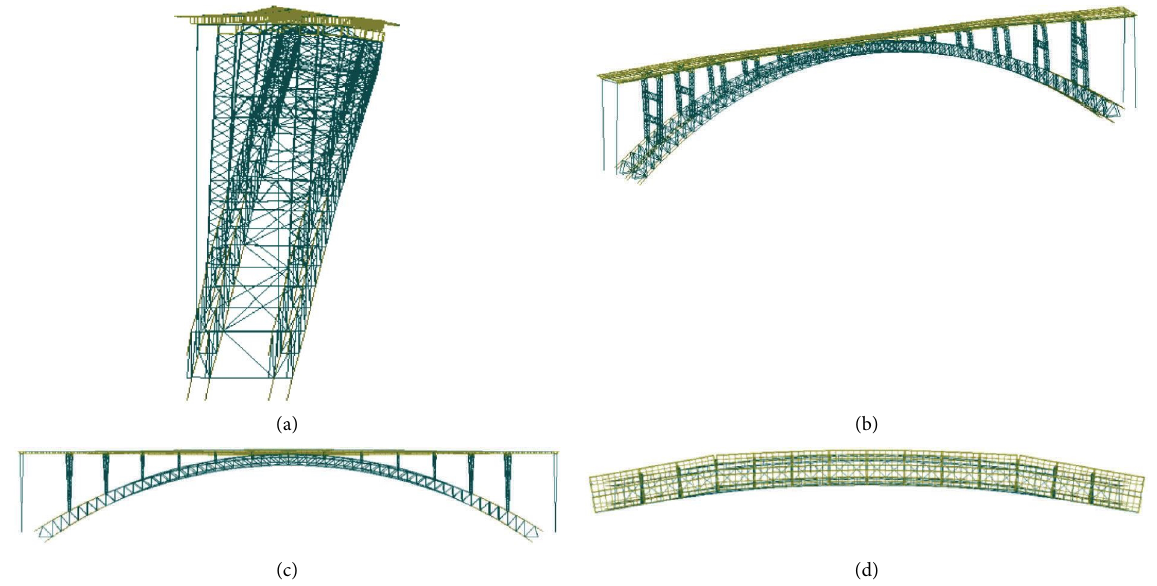
Figure 4: Te frst-order mode shape diagram of the main arch. (a) Side, (b) 3D, (c) facade, and (d)